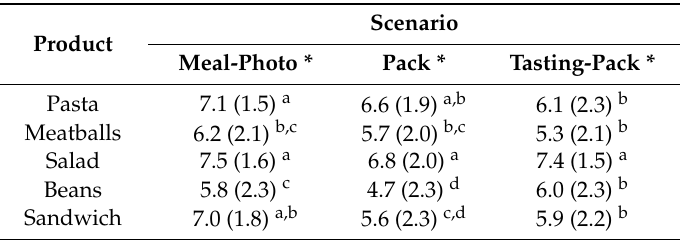
Table 3. Liking mean values, and standard deviation in parenthesis, of the five products evaluated on a plate (Meal-Photo condition), in the pack (Pack Alone condition) and after tasting with the pack in view (Tasting-Pack alone condition).